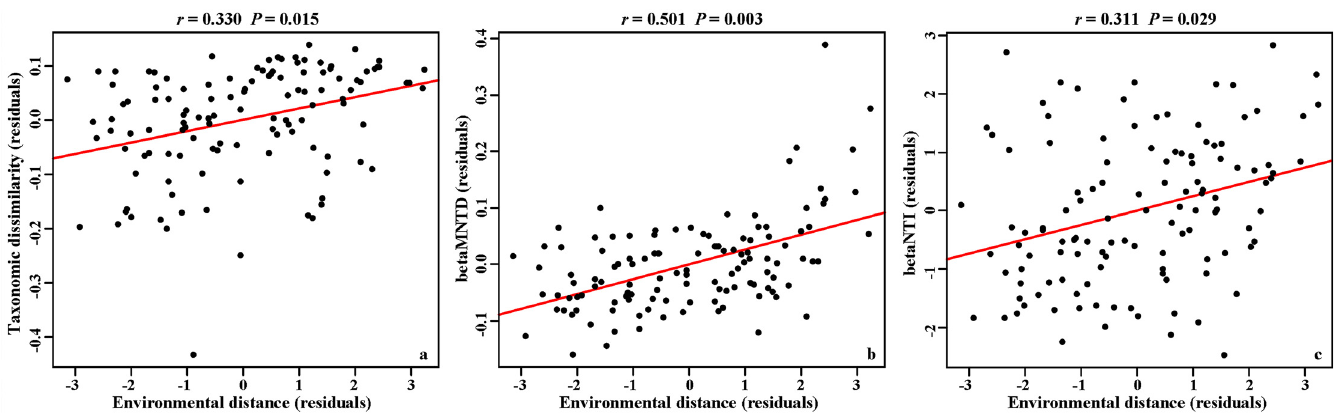
Fig 2. Partial correlation between environmental heterogeneity (environmental distance) and taxonomic dissimilarity (a); and betaMNTD (b); and betaNTI (c). Residuals of the x and y variables are plotted in order to account for the effects of vertical distance and spatial autocorrelation. Solid lines represent linear regressions and the significance levels are determined by partail Mantel tests (9999